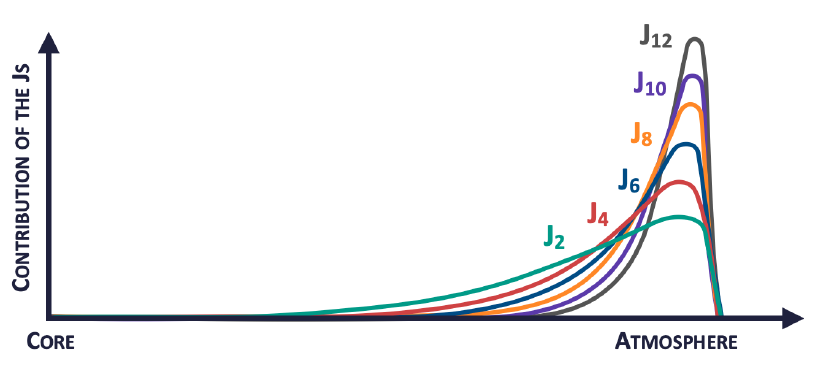
Figure 2. Schematic figure showing the contribution of the gravitational harmonics from the different regions in the interior of the planet. The low-order gravitational harmonics contribute to our under- standing of giant planets’ deep interiors and the high-order gravitational harmonics help to unveil deep atmospheric